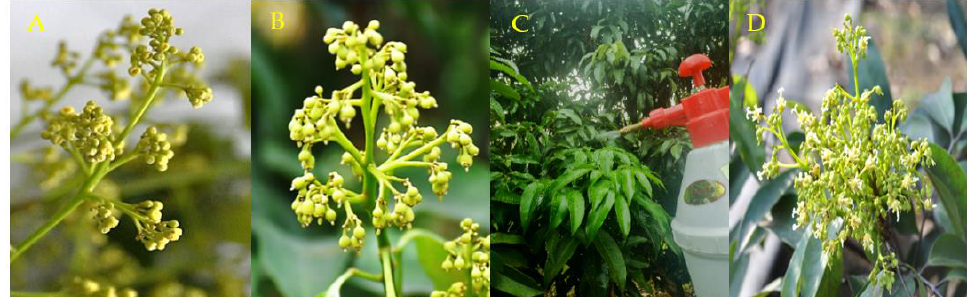
Figure 6. Flower bud nTiO 2 composite reagent and simulation wiper treatment. ( A ): Female flower bud; ( B ): male flower bud; ( C ): flower bud spray nTiO 2 composite reagent; ( D ): artificial pollination simulation of rainwater.